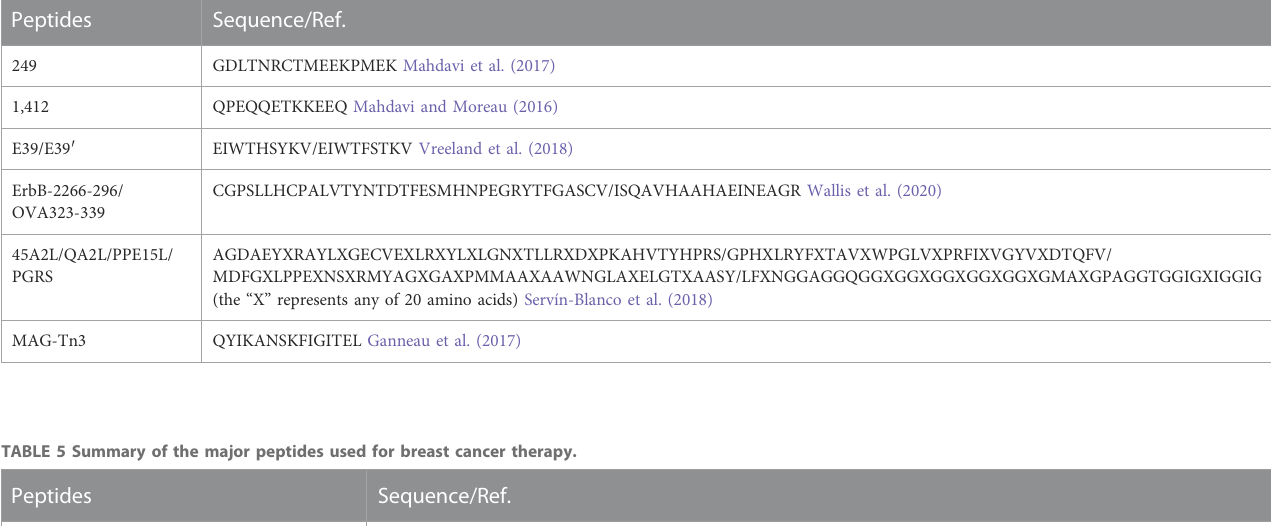
TABLE 5 Summary of the major peptides used for breast cancer therapy. Peptides